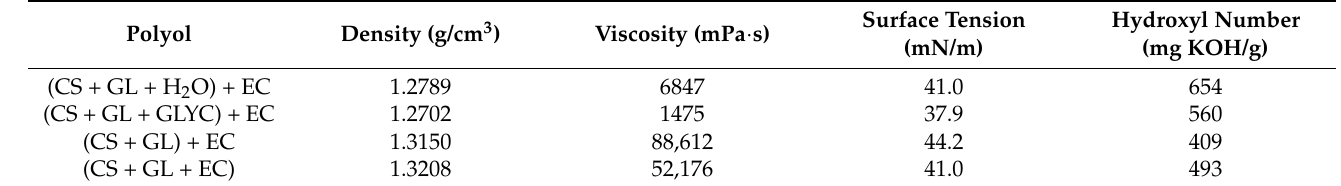
Description of abbreviations used in the table: GL—glycidol, GLYC—glycerol, OE—oxyethylene group from EC, H Table 4. Physical properties and hydroxyl number of polyols at the temperature of 20 ◦